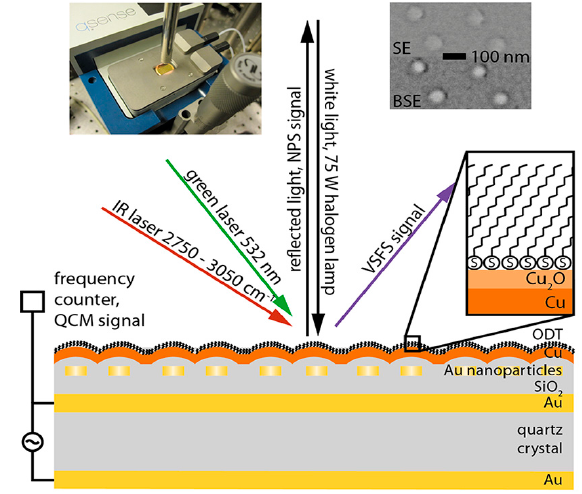
Figure 21. A schematic of the combined QCM-D and indirect nano plasmonic sensor, serving also as the VSFS sample. On the upper electrode of the QCM sensor, the Au nanoparticles for INPS are embedded in a SiO 2 film. On top of this film the actual sample is deposited, a Cu film with a corrosion protective ODT layer. The magnified picture of the latter shows the surface of the Cu film with its layer of Cu 2 O and with the ODT layer on top. The measurement setup is shown on the upper left including an image of the QCM-D window module with the copper coated quartz crystal-Au-nanoparticle-sensor and the reflection probe for INPS. The two SEM images (upper right), one taken with a secondary electron (SE) detector and the other with a backscattered electron (BSE) detector, show the sample surface and the INPS sensing Au nanoparticles. The low contrast in SE points to the fact that the Au nanoparticles are well covered by the SiO 2 layer and have no major influence on the surface roughness. Reprinted with permission from reference [117], Copyright 2013, American Chemical Society.